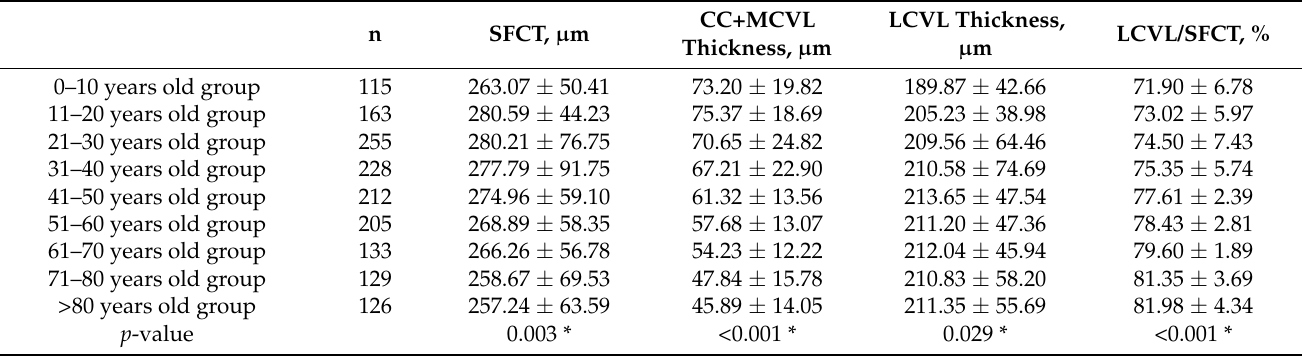
Table 3. Comparison of SFCT, CC+MCVL thickness, LCVL thickness, and LCVL/SFCT in various age